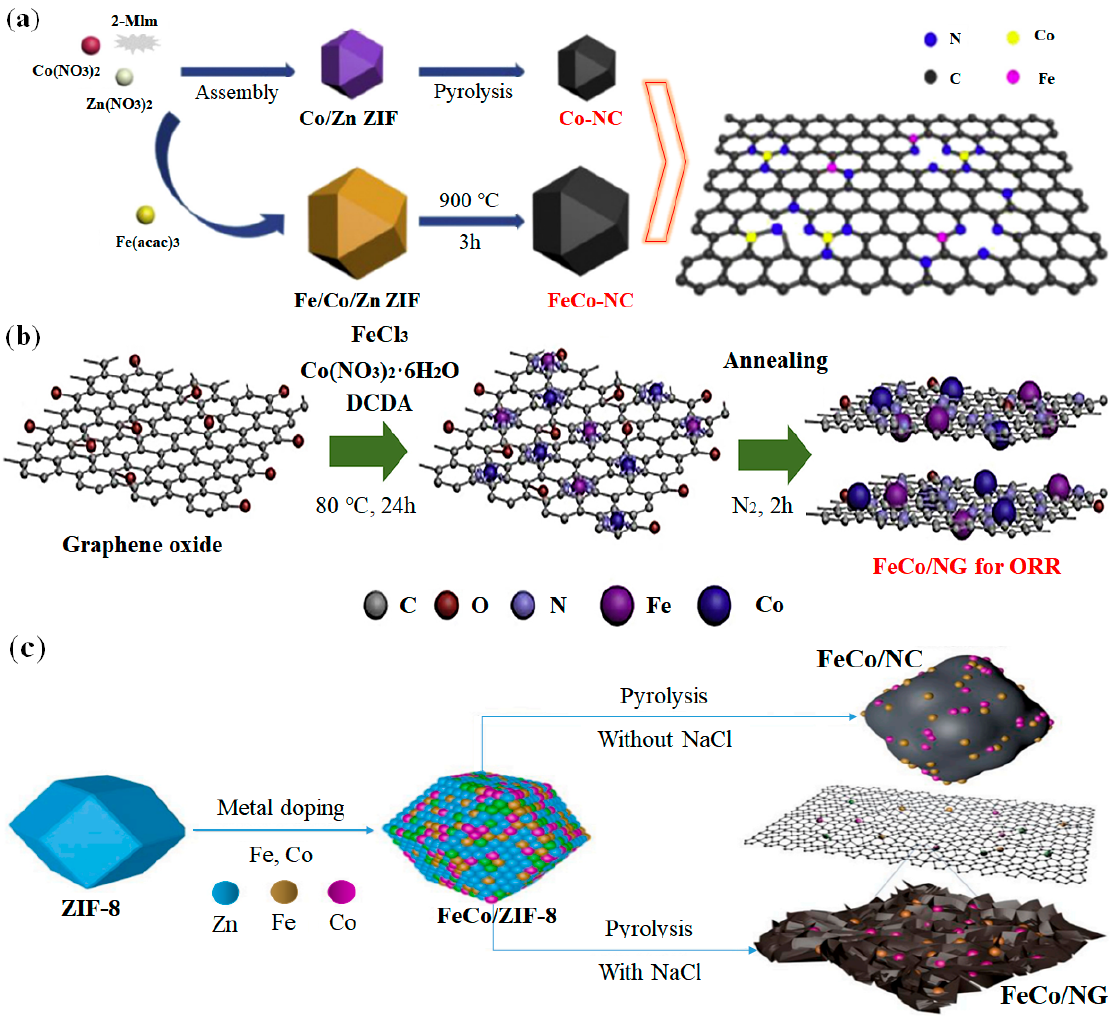
Figure 9. Synthesis methods of FeCo-DACs: ( a ) Synthesis strategy of FeCo-NC catalyst. Adapted with permission from Ref. [119]. Copyright 2018 Elsevier. ( b ) Synthesis strategy of FeCo-NG catalyst. Adapted with permission from Ref. [120]. Copyright 2020 Elsevier. ( c ) Synthesis strategy of FeCo-NC and FeCo-NG catalysts. Adapted with permission from Ref. [121]. Copyright 2022 Elsevier.